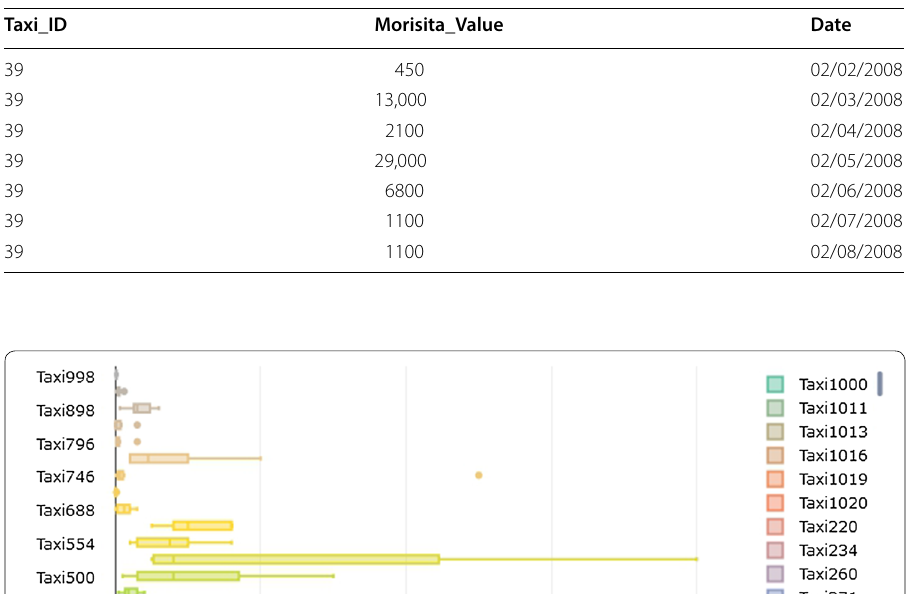
Table 2 Morista value generated by tracking data per day